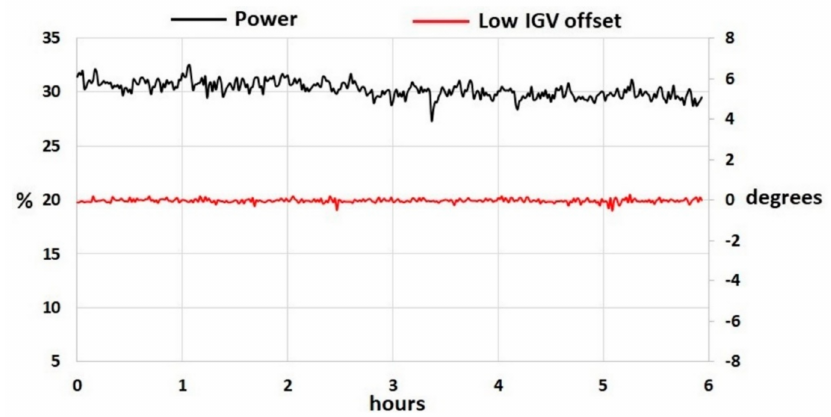
Figure 30. Measured power and at low IGV